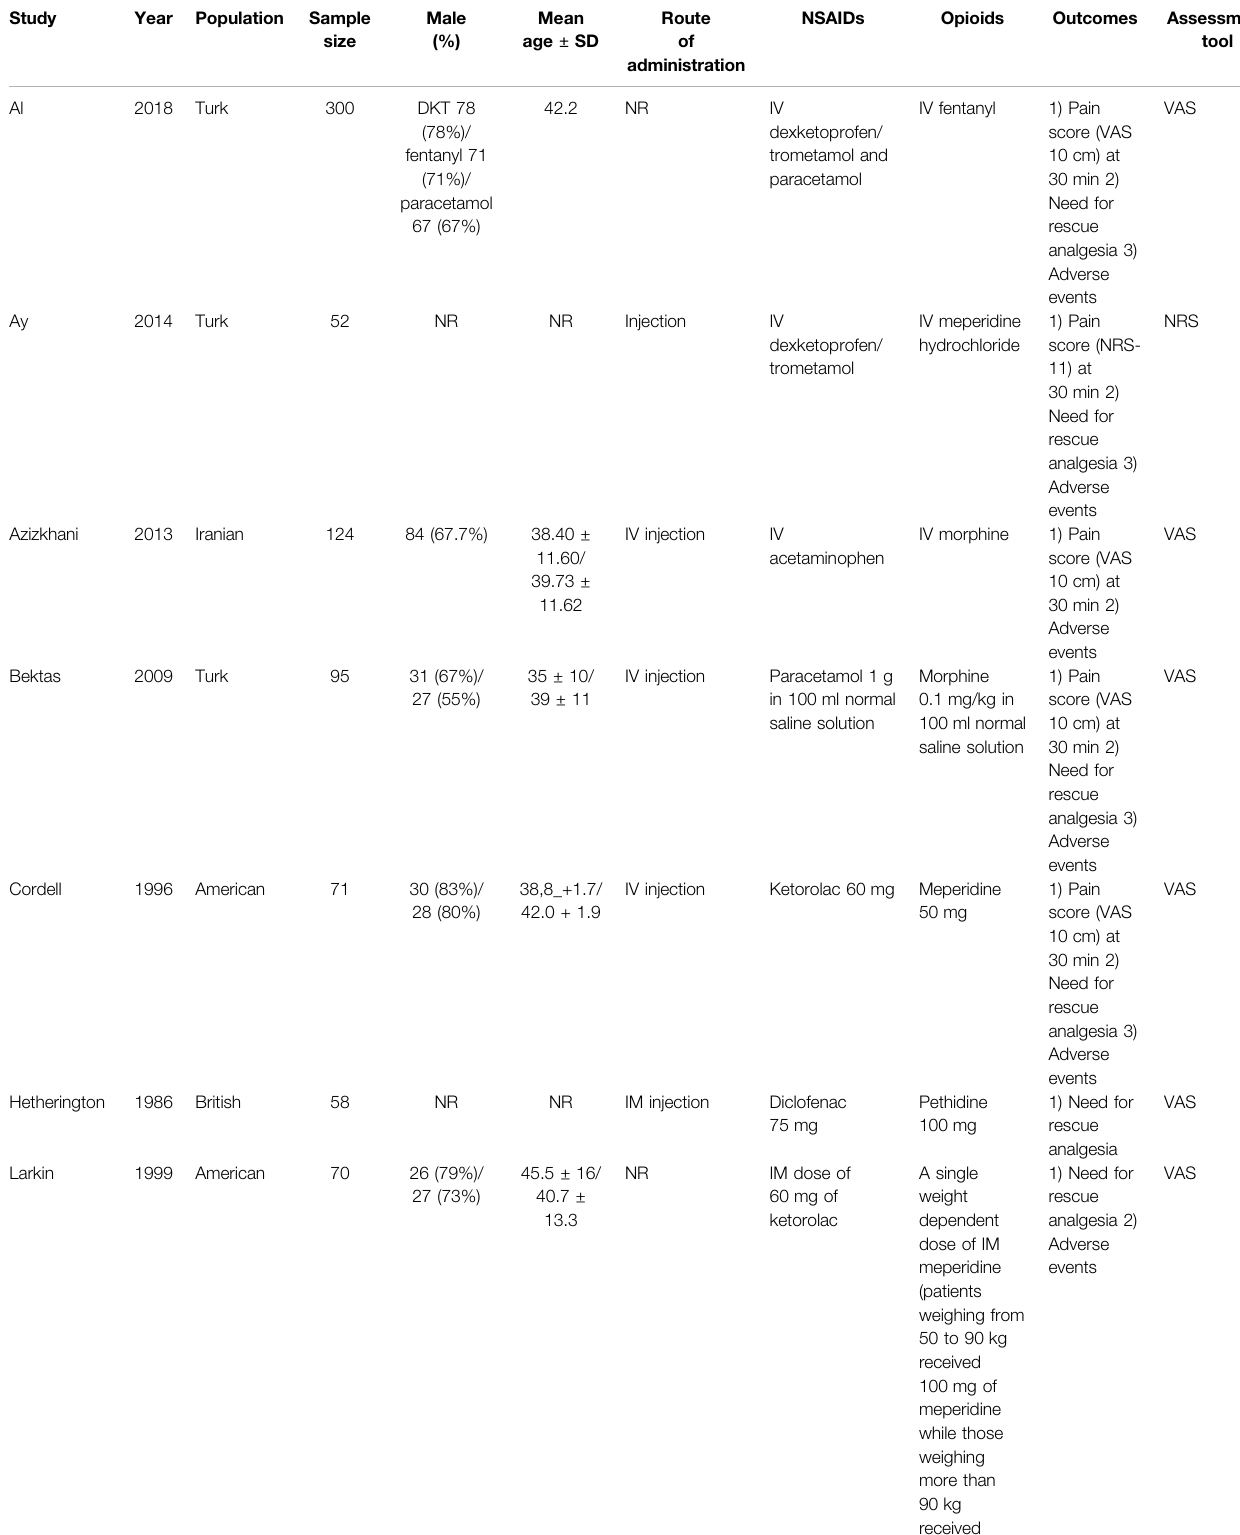
TABLE 1 | Summary of included clinical trials and patient